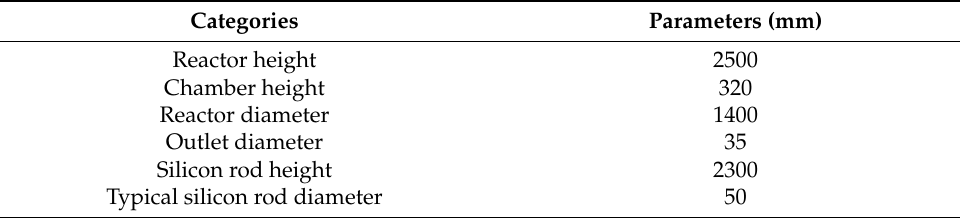
Figure 1. Schematic diagram of bell-type polysilicon reduction furnace: ( a ) Profile; ( b ) Furnace shell and silicon rod. Table 1. Geometrical dimensions of the model of 18-rod CVD reactor.